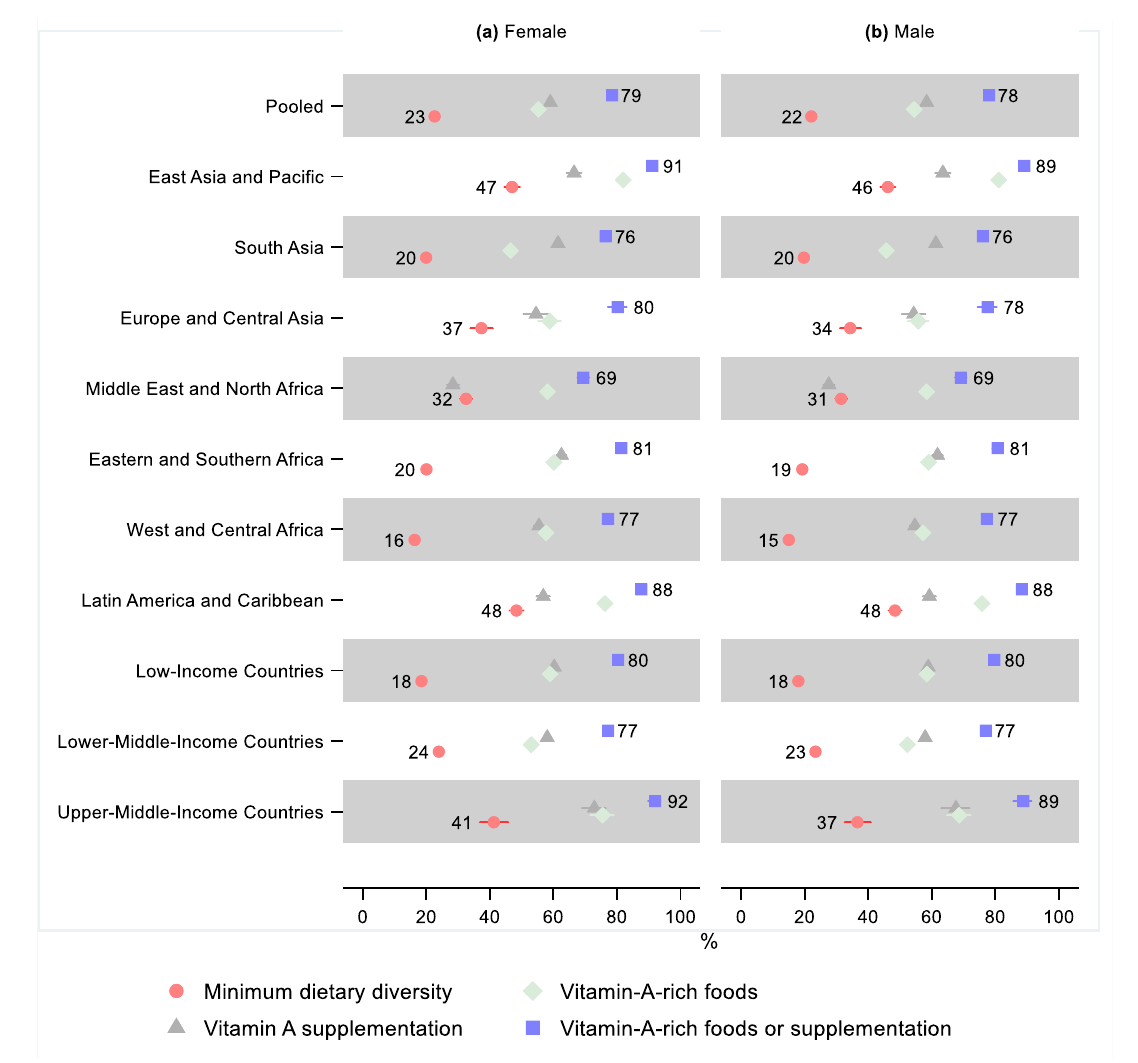
Figure 3. Percentage of children 6–23 months old that received the minimum dietary diversity, vitamin-A-rich foods, vitamin A supplementation, and either vitamin-A-rich foods or vitamin A supplementation in low- and middle-income countries by sex. Notes: 95% confidence intervals are shown. Some confidence intervals may be narrower than the symbol for the estimate and therefore not visible. See Tables S5–S8 in the Supplement for the tabulated estimates and confidence intervals. See Figures S1–S4 in the Supplement for the plotted relative differences.